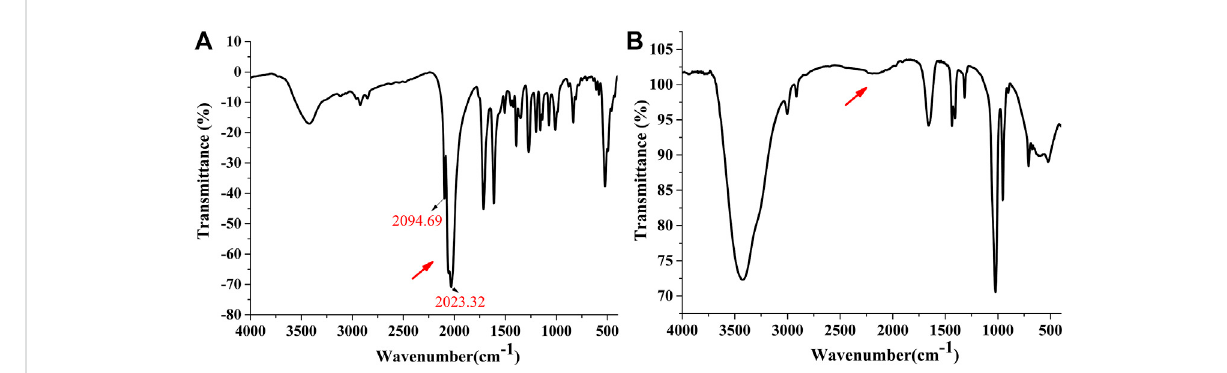
FIGURE 3 The infrared spectrum of complex 5 [The solid powder (A) ; incubated at 37 ° C, 0.1 M PBS, pH = 7.4 for 24 h (B) ].